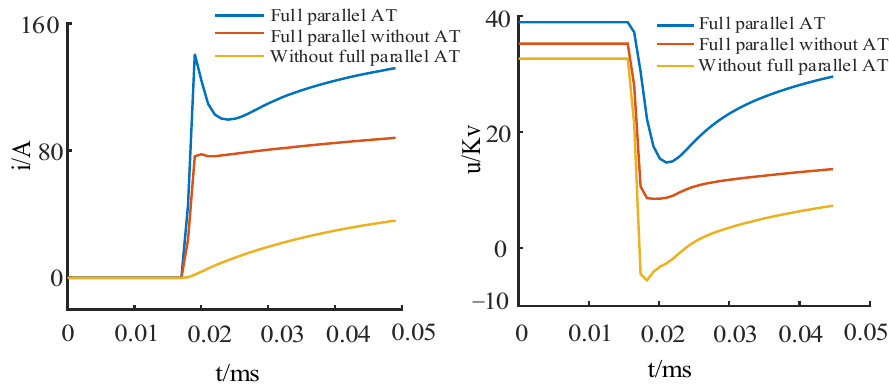
Figure 3. Influence of full parallel and AT structure on traveling wave.